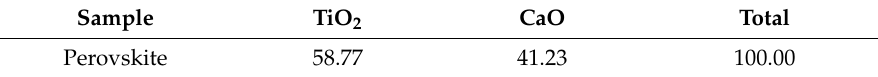
Table 1. Chemical composition of perovskite sample (mass fraction,